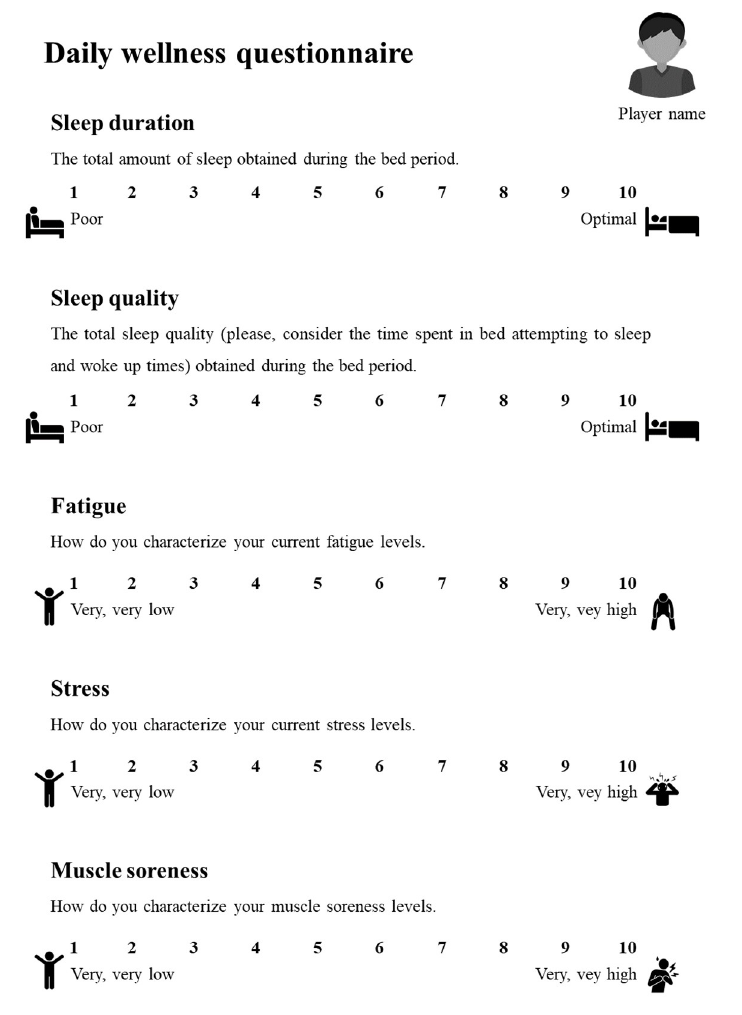
Fig 2. Daily wellness questionnaire administered to all players before each training